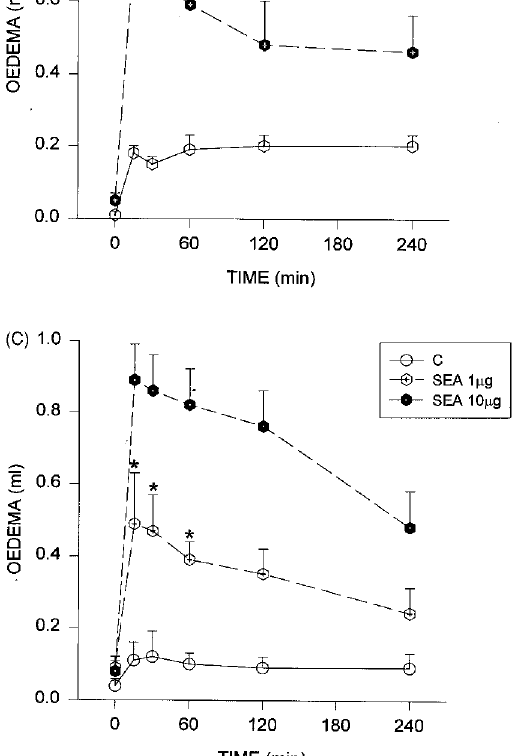
FIG. 2. Intraplantar injection of SEA ( S. mansoni Soluble Egg Antigen) in rats reproduces the oedematogenic response induced by challenge of sensitized rats with S. mansoni eggs. In (A), it is shown the oedematogenic effect induced by different doses of eggs in sensitization ( n =4–6). In (B), the oedematogenic effect induced by a second injection of eggs in rat paws is shown ( n =4–6). In (C), 1 or 10 m g/site of SEA were injected i.pl. instead the eggs in challenge ( n =3–6). Measurements were obtained in a hydroplethysmother (Ugo Basile) at zero, 15, 30, 60, 120 and 240min following i.pl. administration of the 40 or 200 eggs in 0.1ml of physio- logical saline/site [E]. Mediators of Inflammation · Vol 7 ·